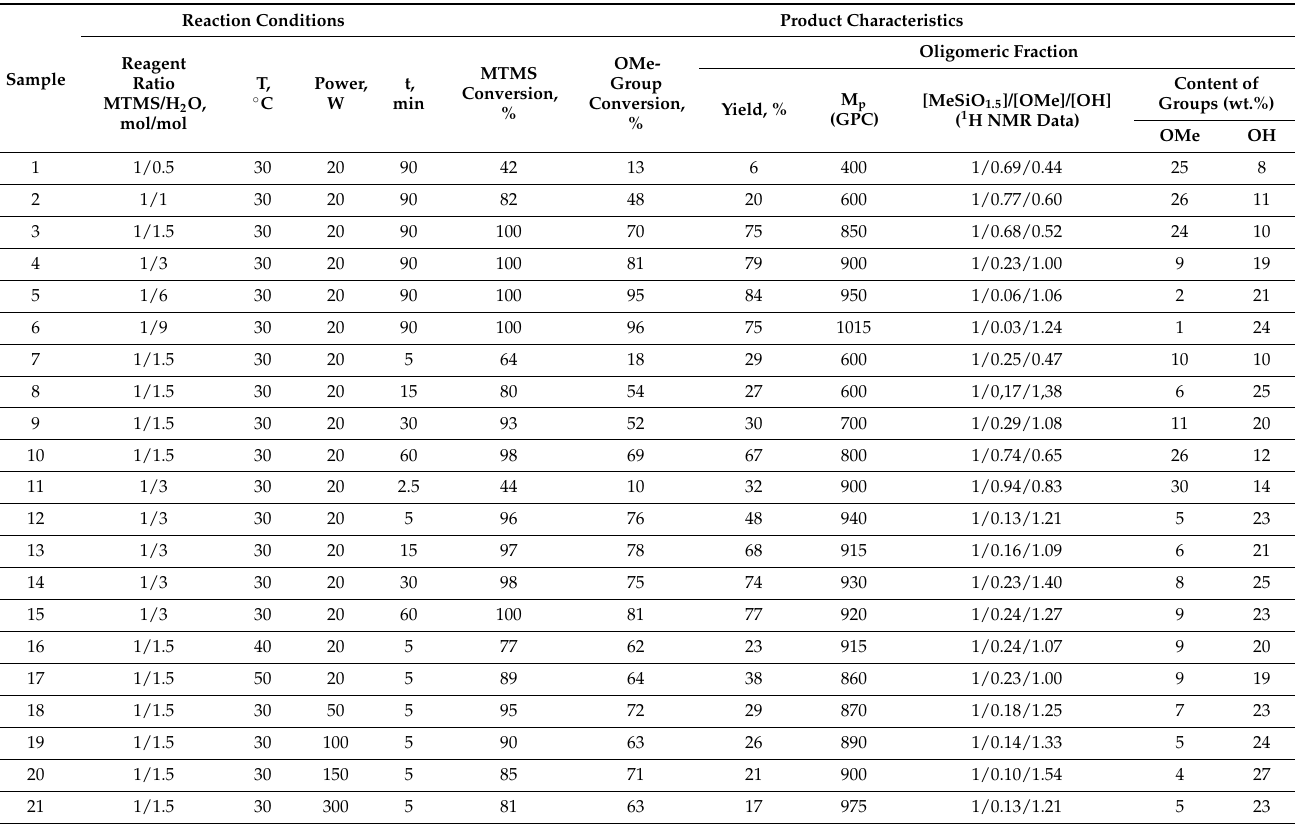
Table 1. Reaction conditions and composition of MTMS MWHP products.